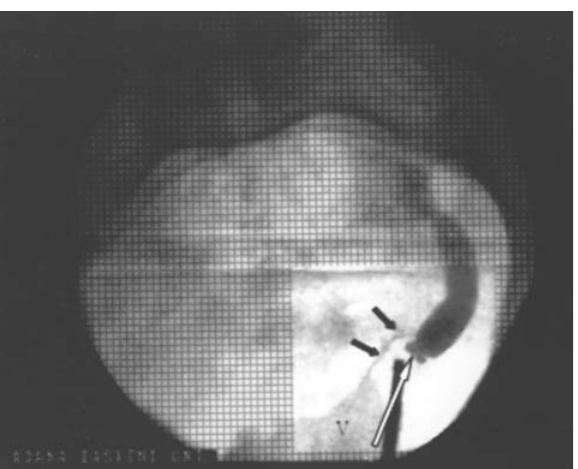
Figure 1 – Antegrade ureterography of the patient with distal ureteral obstruction and concomitant ureterovaginal fistula show- ing the ureterovaginal fistula tract (black arrows) and complete ureteral obliteration. ‘V’ is showing the contrast filled vagina. Ureteroscope is in the distal ureter and with the guidance of C- arm fluoroscopy, is positioned in the correct plane toward the proximal ureter (white arrow).